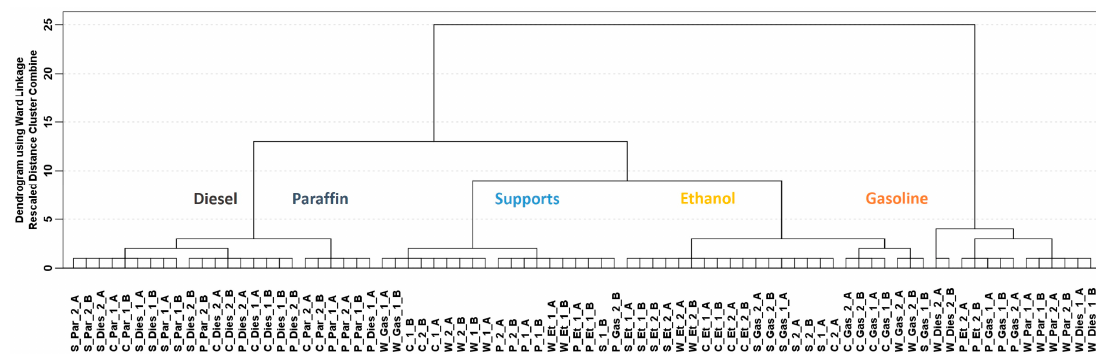
Figure 1. Dendrogram obtained from hierarchical cluster analysis (HCA) on the fire debris samples (D 80 × 4286 ) using TIC chromatograms. (Samples are denoted as the IL code followed by the substrate: Gasoline (Gas), Diesel (Dies), Paraffin (Par) and Ethanol (Et), cotton sheet (S), paper (P) for pinewood (W) and for cork (C). A y B is used for the replicates.